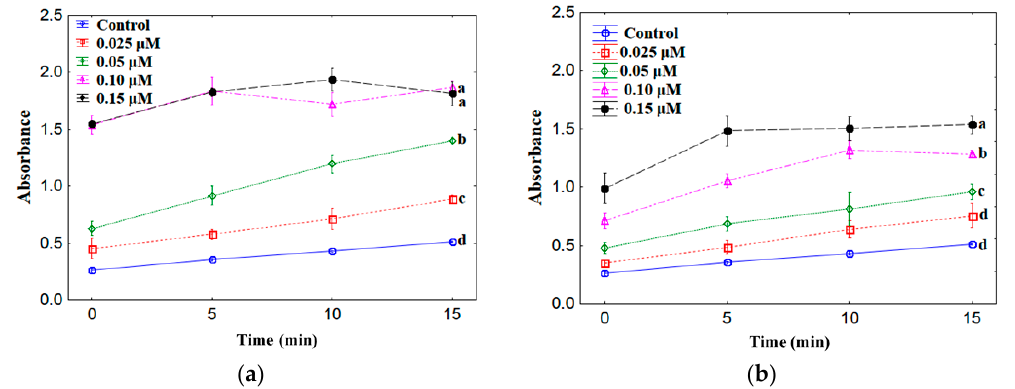
Figure 1. The effect of different concentrations (0.025–0.15 μ M) of ( a ) zinc complex of chlorogenic acid and ( b ) chlorogenic acid on the oxidation of trolox. Mean values from three independent experiments ± standard deviation (SD) are shown. The same letter near the means indicates no significant difference (Tukey test, p < 0.05).